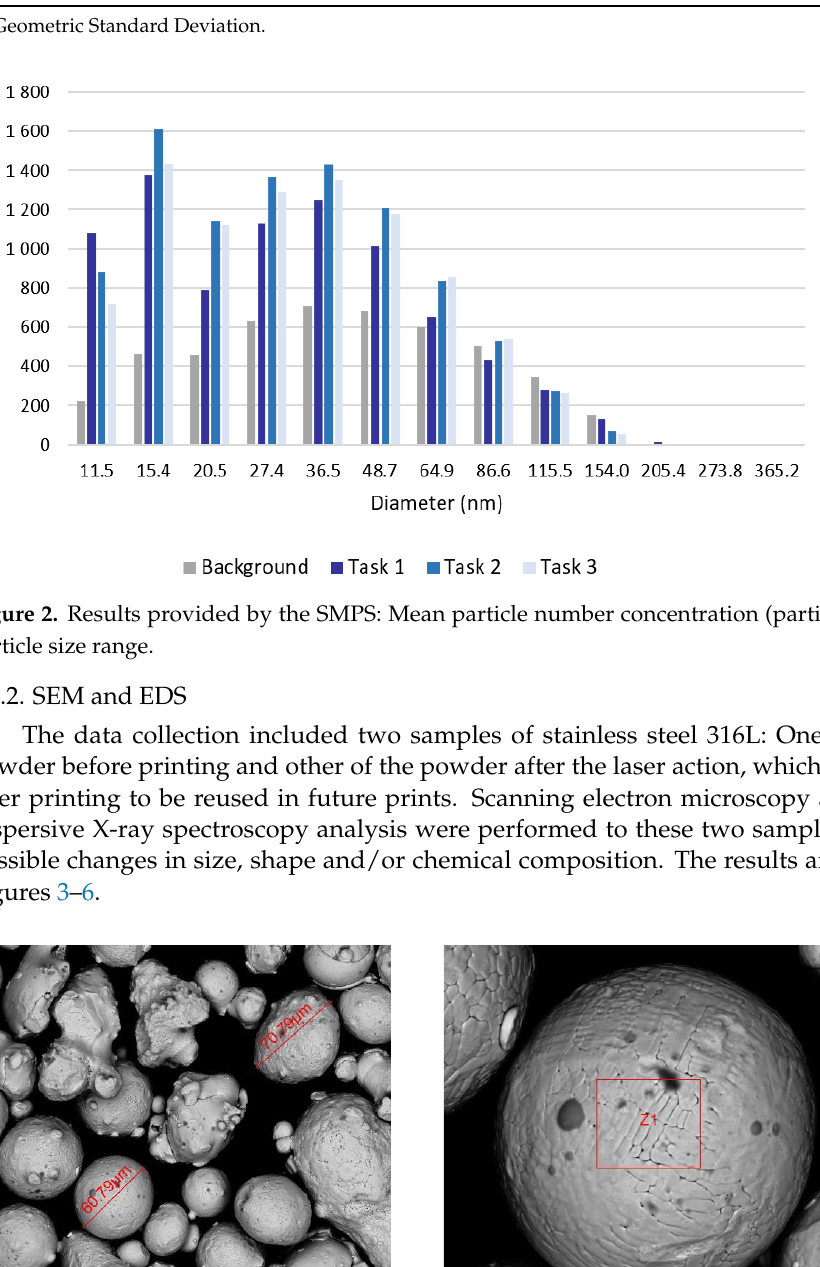
Figure 4. EDS analysis results: Stainless steel 316L raw powder, before any AM process. ( a )